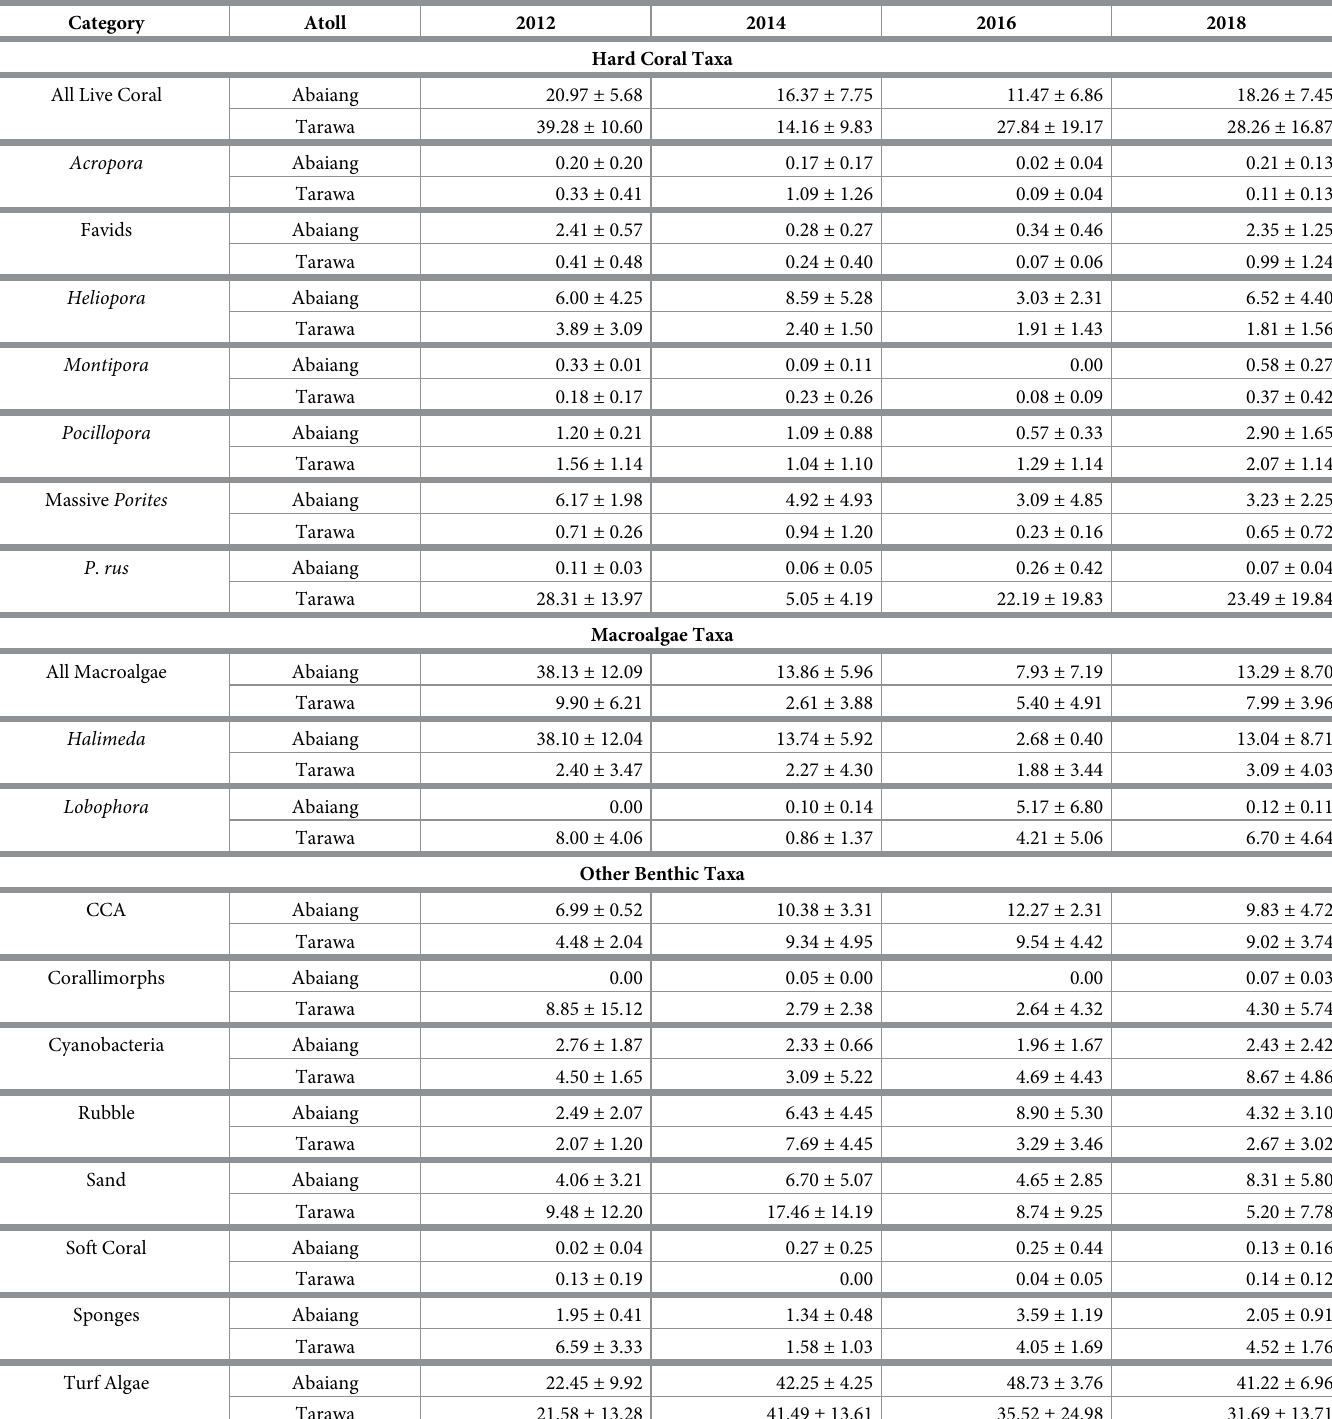
Table 1. Mean and standard deviations of the percent cover of key benthic category, for each survey year by atoll.